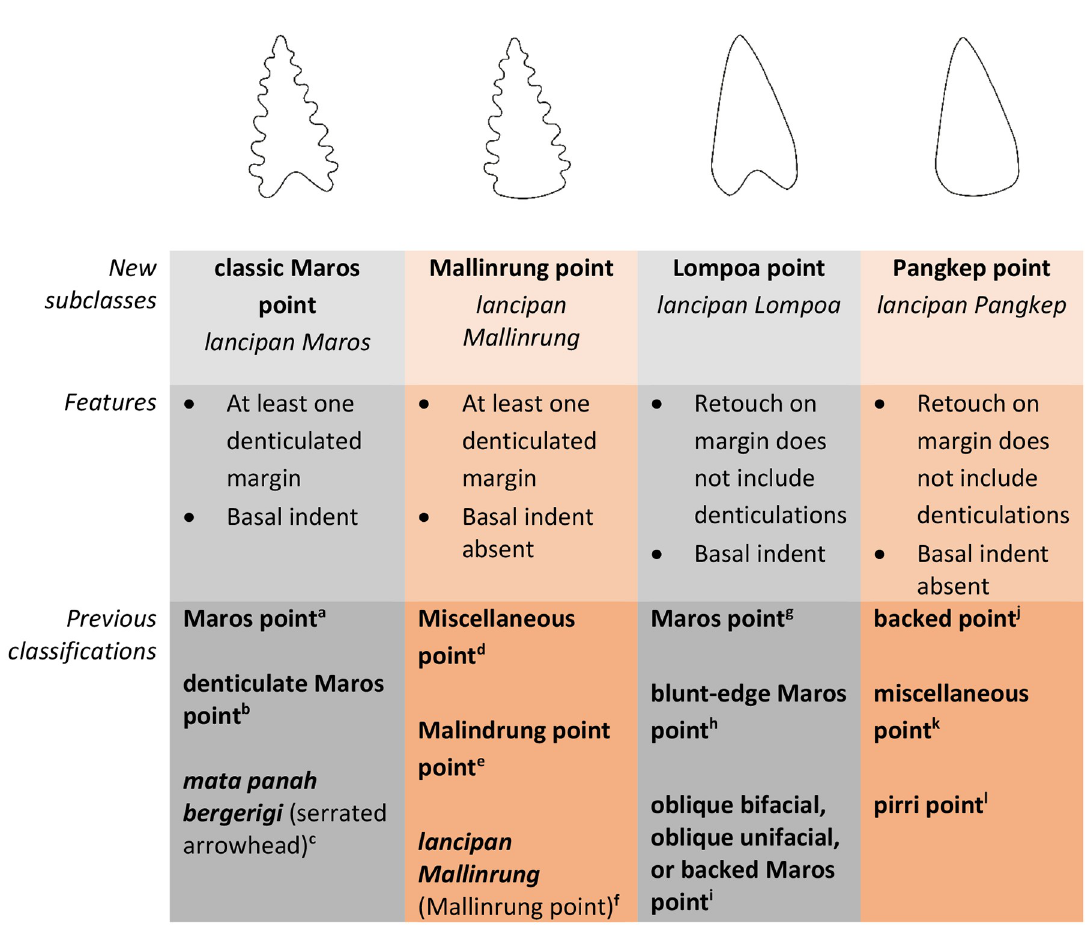
Fig 12. Subclasses of Toalean retouched points. a [e.g. 8, 50, 55, 57, 123, 141], b [28, 85], c [25], d [8], e [20, 50], f [139], g [8, 55], h [28],